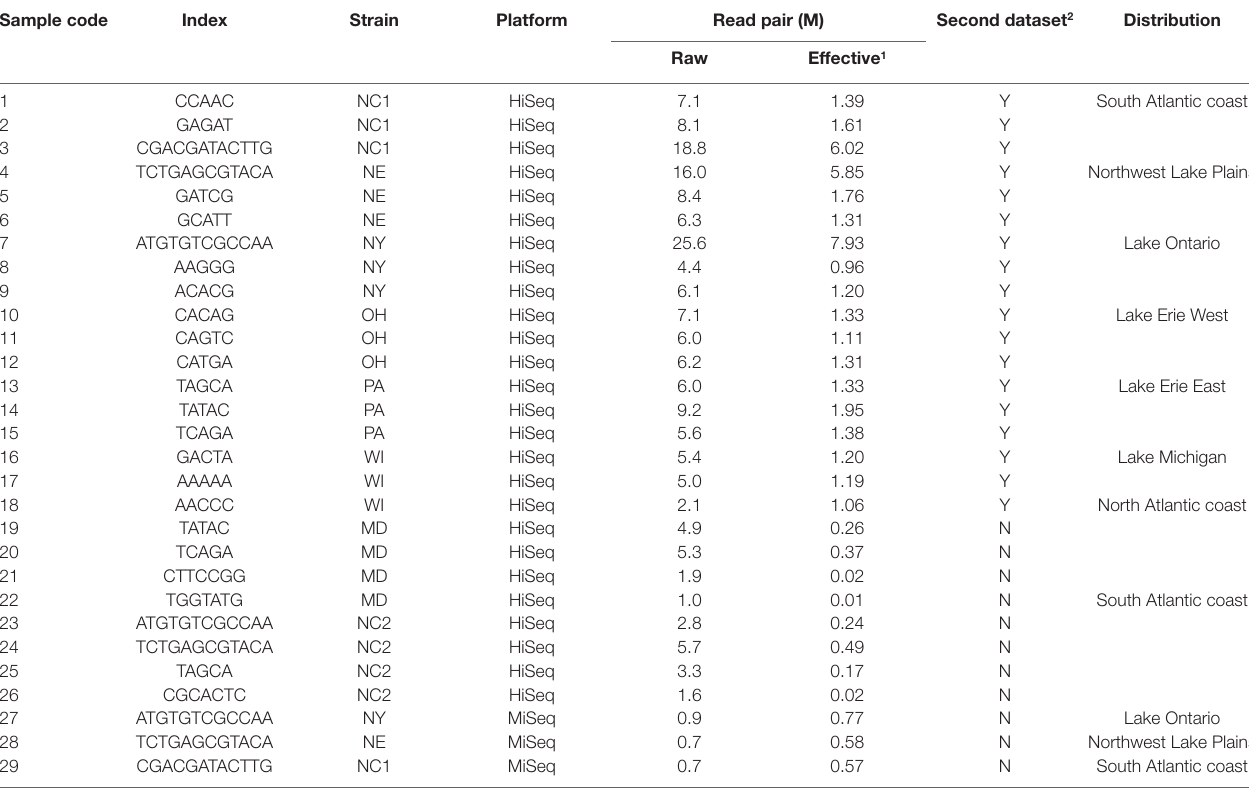
TABLE 1 | Description of samples and statistic of reads. Sample